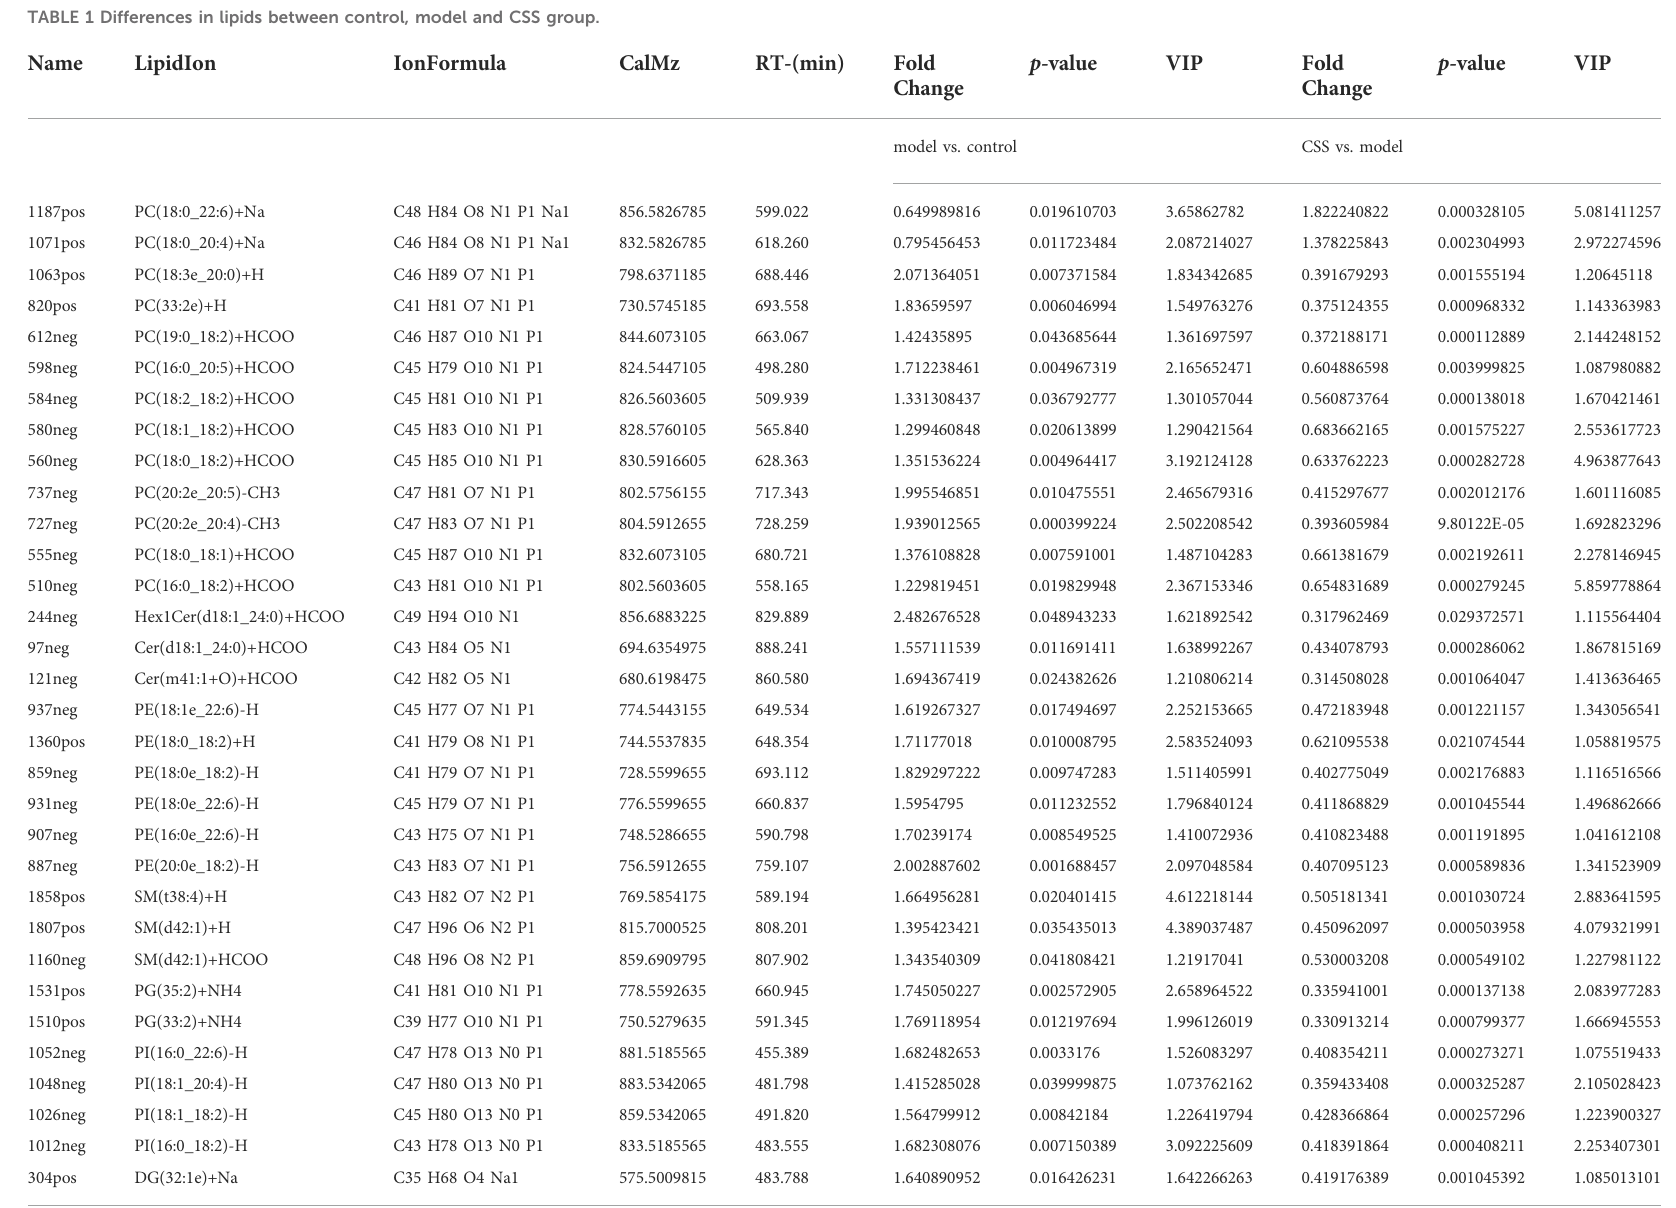
TABLE 1 Differences in lipids between control, model and CSS